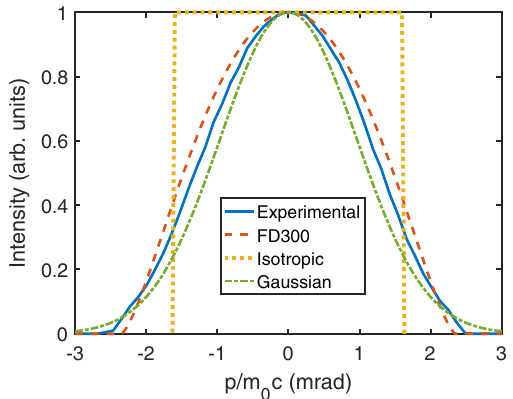
FIG. 9. The beam size variation with charge at the observation screen both in experiment and in simulation are presented. The laser diameter is 1 mm and the length is around 2.55 ps rms. The solenoid current is set to the imaging condition.